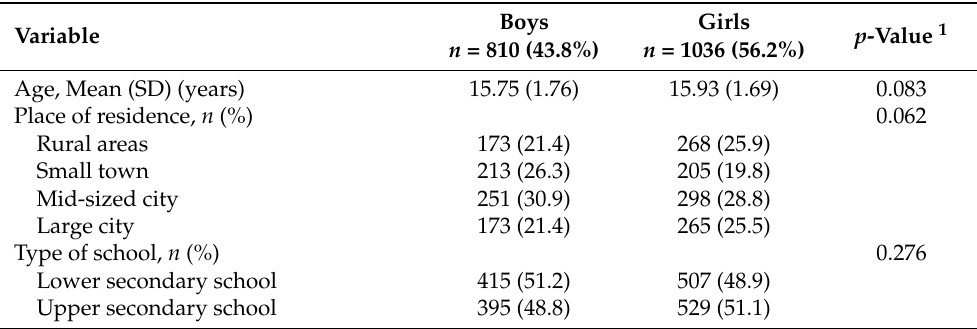
Table 1. Candidate predictor factors of perceived stress: sample distribution according to